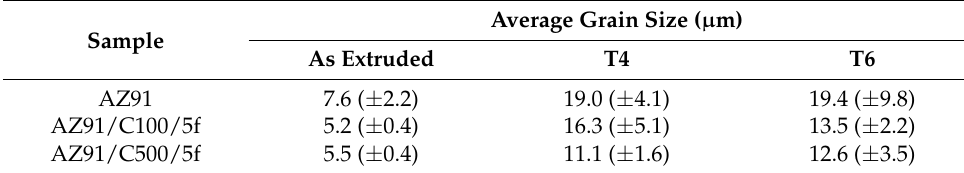
Table 4. Average grain size of samples in µ